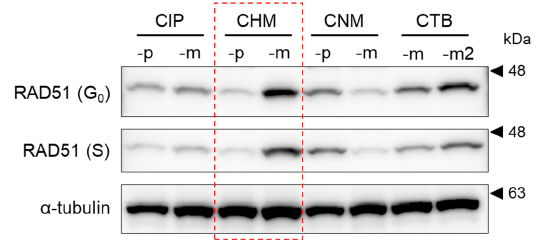
Figure 1. Analysis of RAD51 expression in eight canine mammary tumor cell lines. RAD51 expression status in the G 0 and S phases in double thymidine-blocked mammary tumor cell lines was analyzed using western blotting. α -tubulin was used as a loading control. CHMp and CHMm derived from the same individual with markedly different RAD51 expressions are indicated by red dotted boxes.